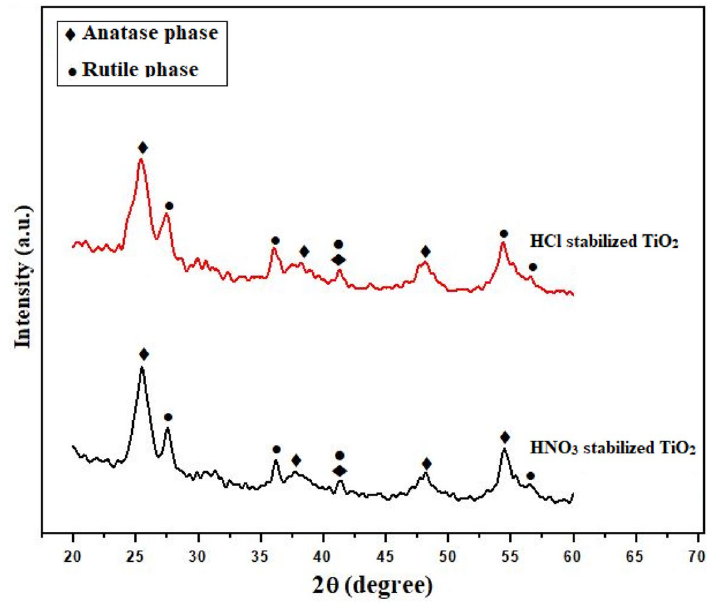
Figure 2. XRD patterns of TiO 2 nanoparticles stabilized with HCl and HNO 3